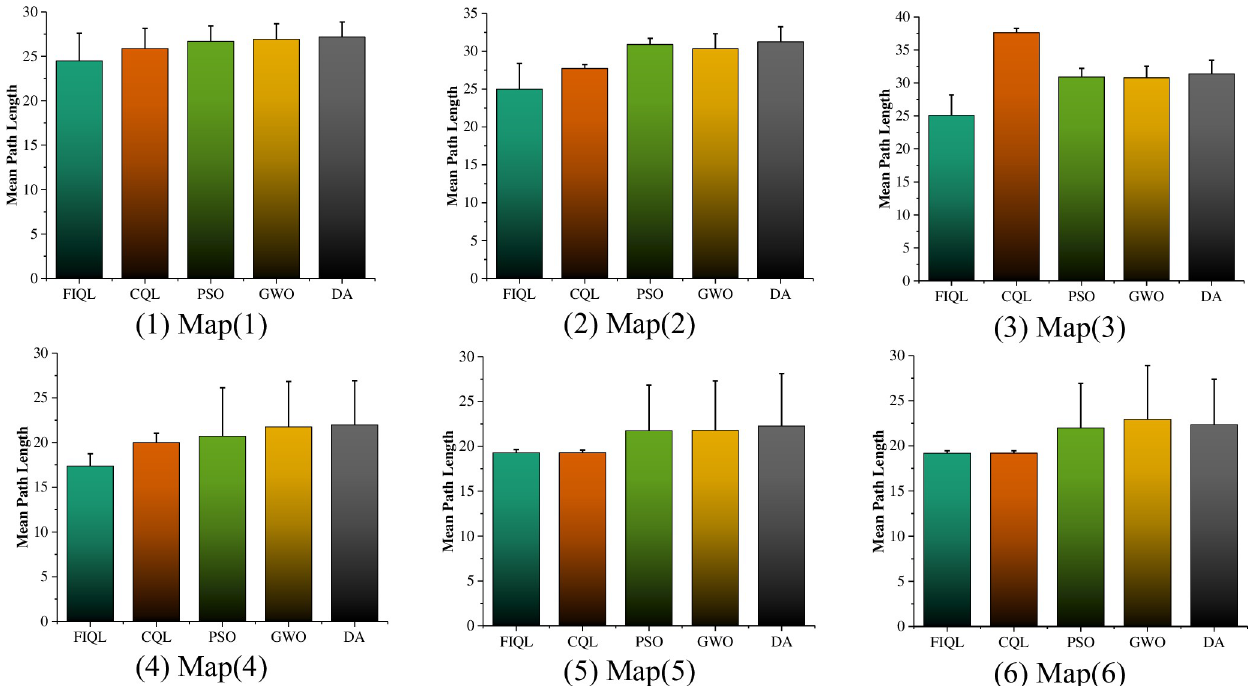
Fig 9. Mean path length of different algorithms in typical grid map for SAR